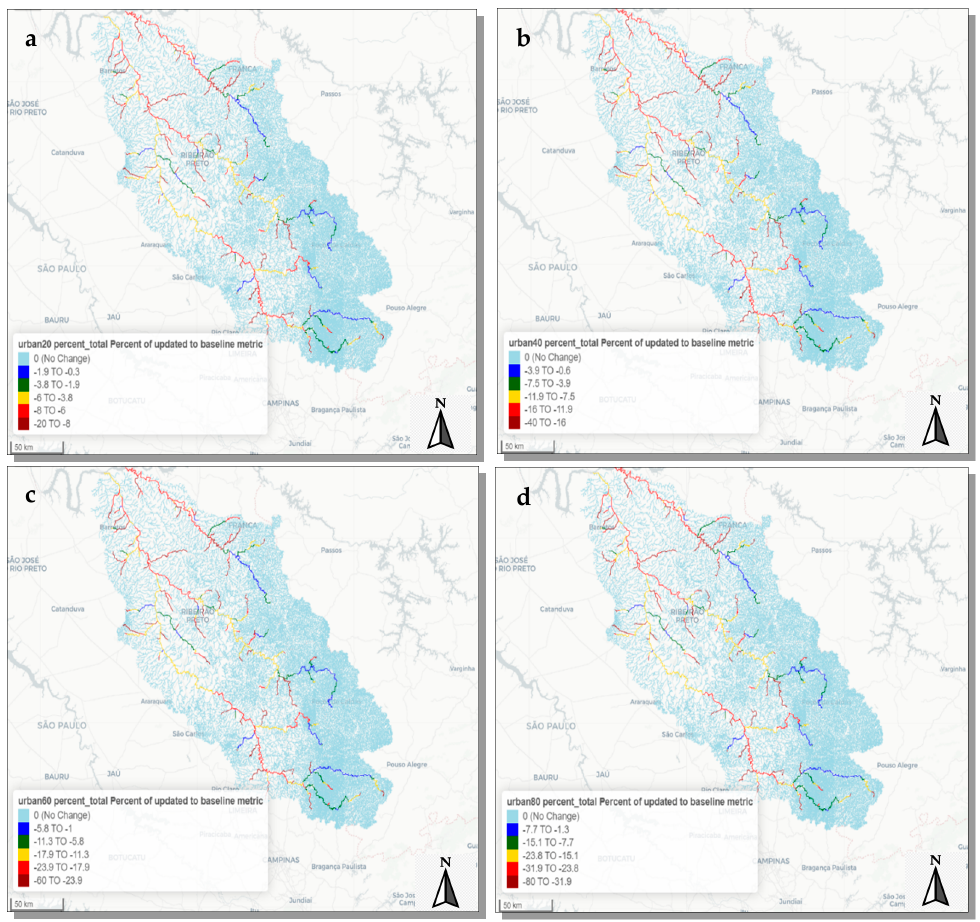
Figure 4. Map showing the predicted percent reduction in TN load in response to hypothetical reductions in TN mass inputs from wastewater treatment plants of ( a ) 20%, ( b ) 40%, ( c ) 60% and ( d ) 80%. The colors in the map represent different predicted percent reductions in TN stream load as a function of the percent change in TN mass input from wastewater treatment plants. Note the differences in bin ranges among maps.